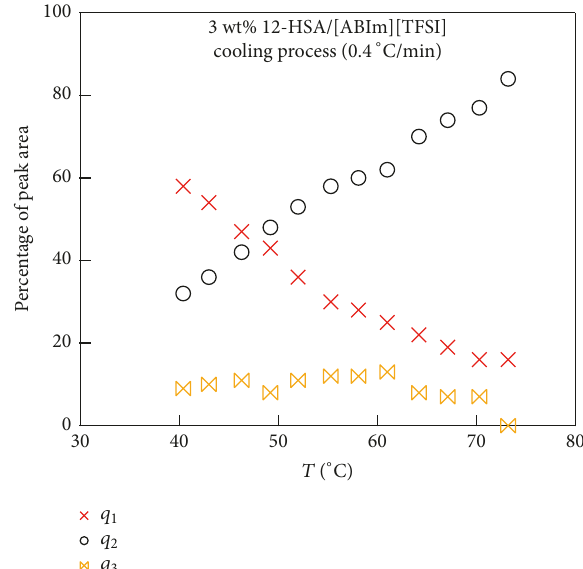
Figure 5: The percentage of each peak area for 3 wt% 12-HSA/[ABIm][TFSI] gel during the cooling process at a rate of 0.4 ∘ C/min.